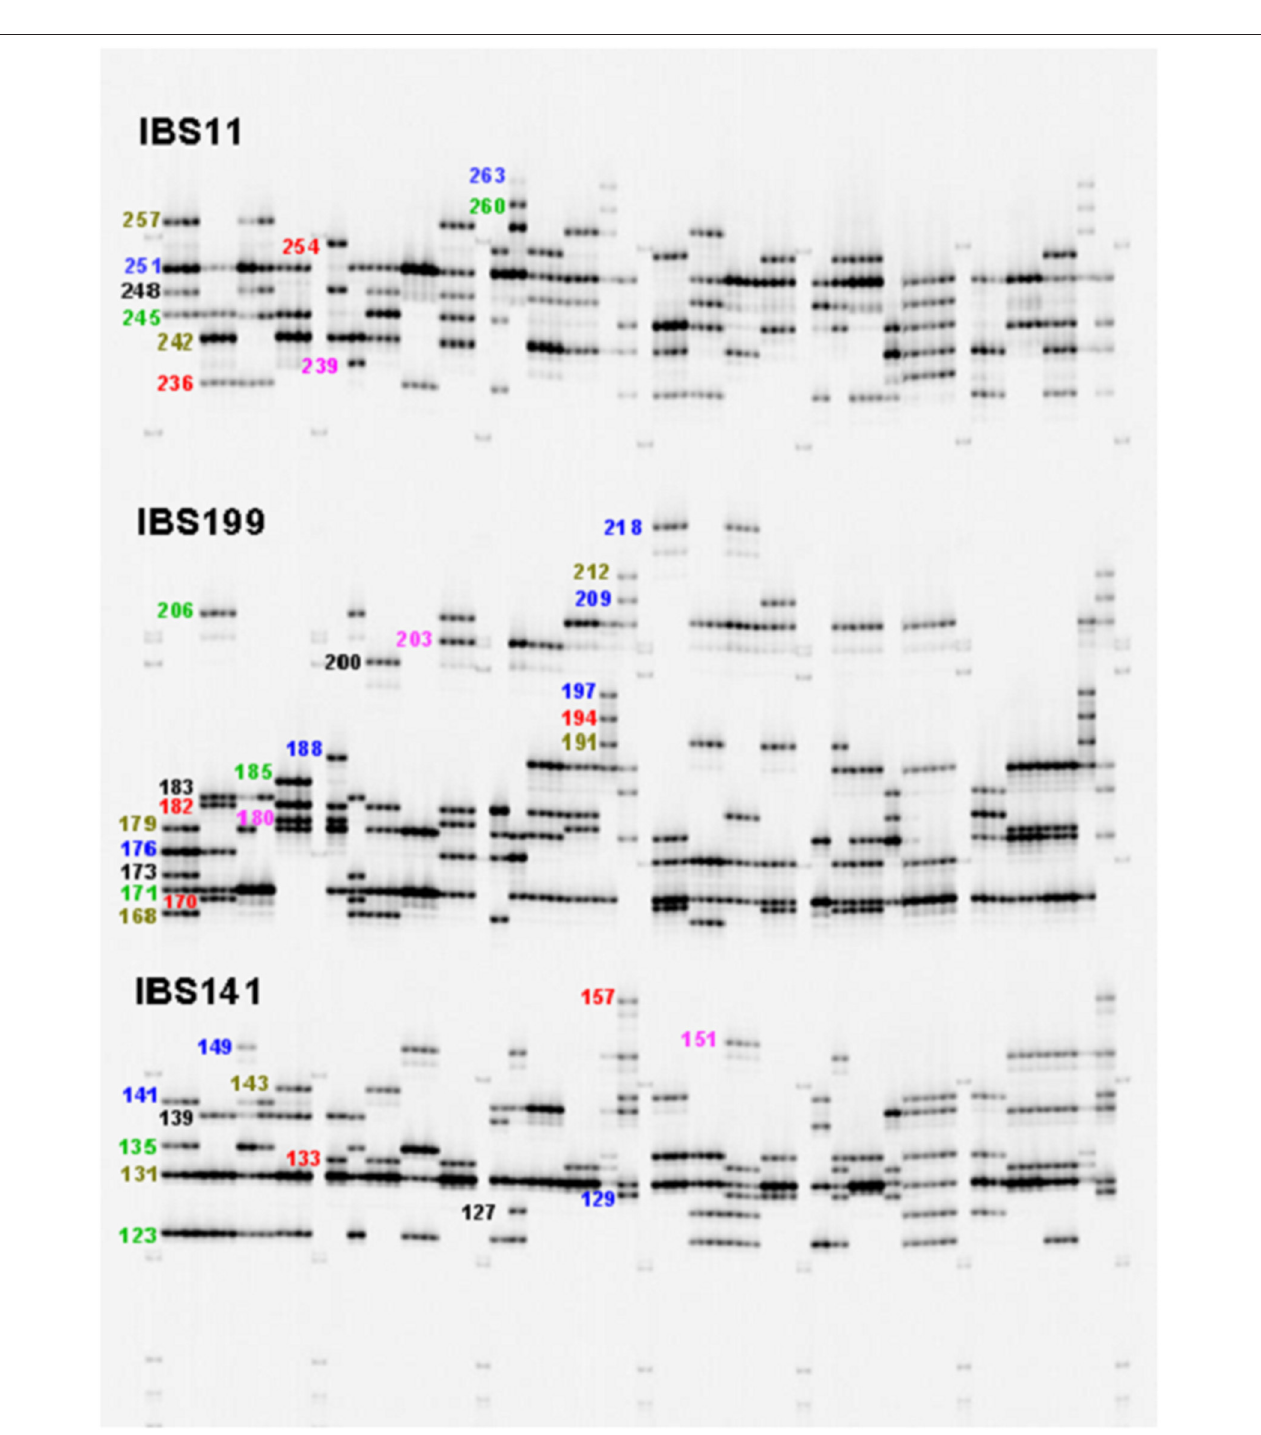
FIGURE 1 | LI-COR electrophoresis gel image for three SSR loci (IBS11, IBS199, and IBS141) that were multiplexed in a single reaction, with approximate allele sizes.